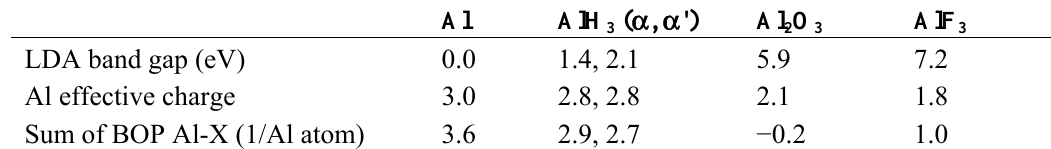
Table 1. Comparison of calculated band gap, effective charge, and BOP of Al-containing compounds (including AlH 3